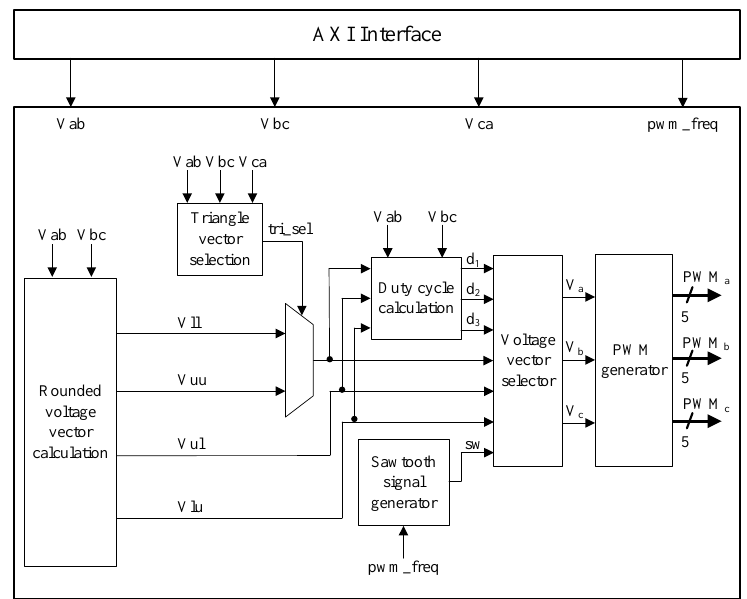
Figure 18. Block diagram of the implemented SVM.